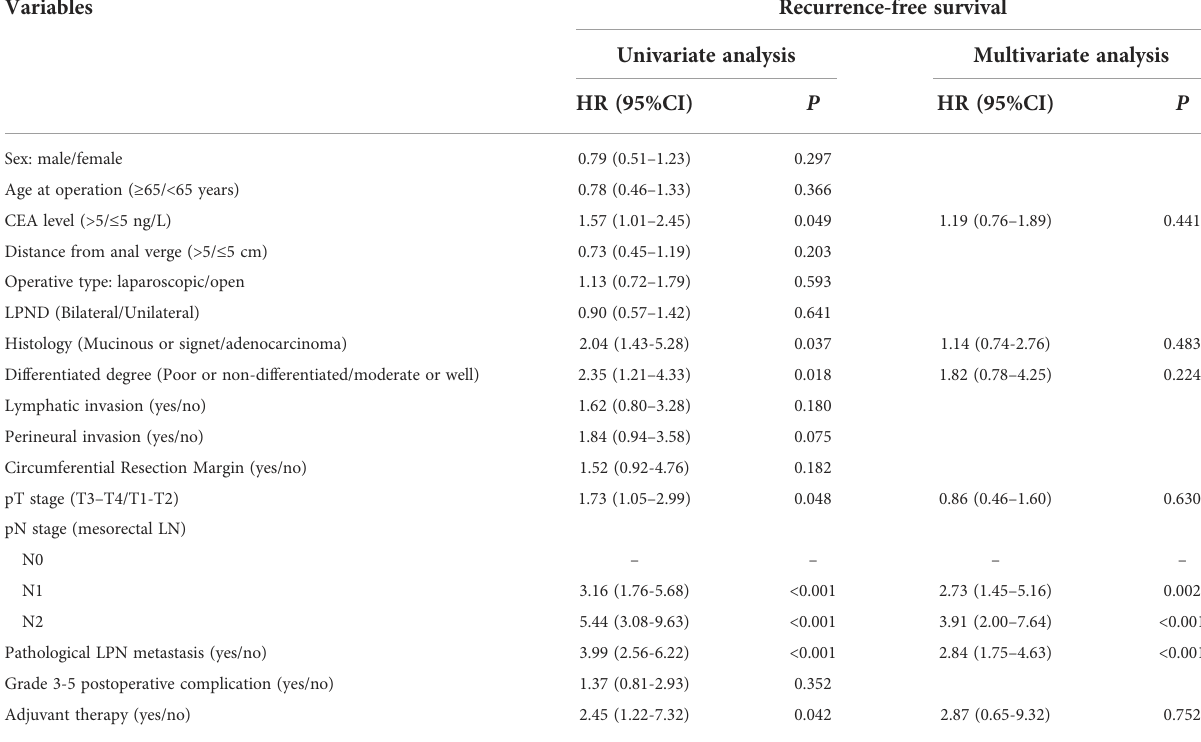
TABLE 3 Univariate and multivariate regression analyses of recurrence-free survival in 387 patients with clinical LPN metastasis who underwent TME+LPND.